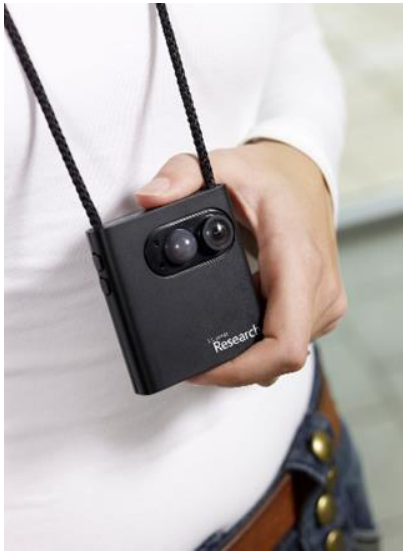
Figure 1. The Microsoft ® SenseCam digital camera and how it is worn by participants .